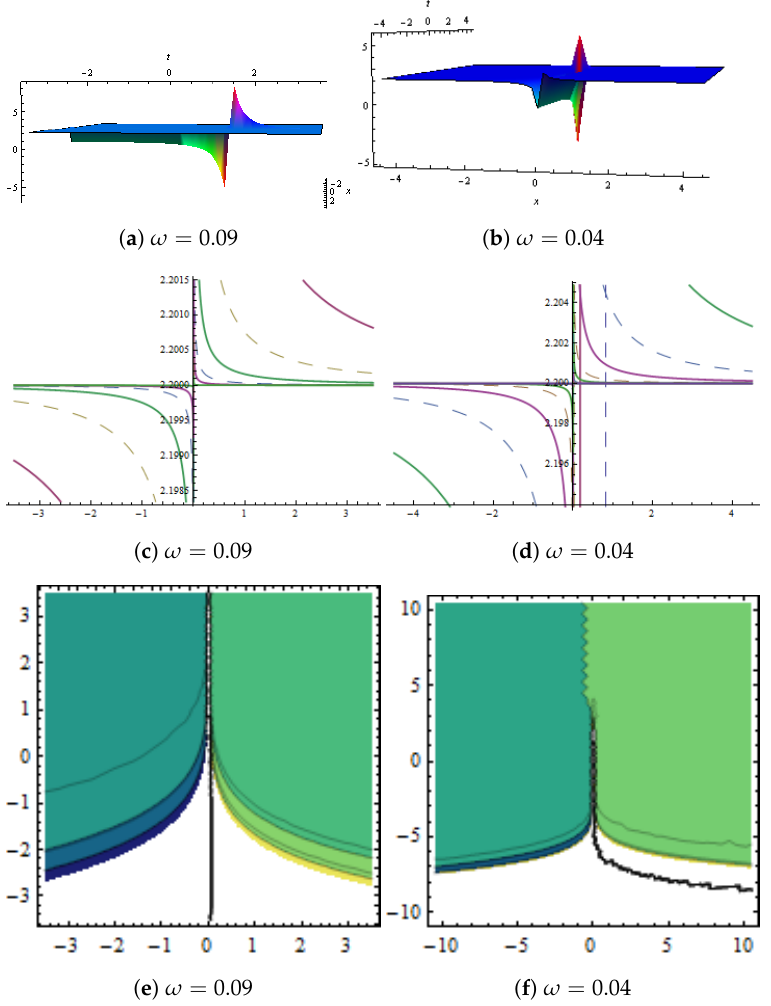
Figure 21. Graphical representation of solution v ( x , t ) in Equation (51) with β 2 = 0.2, β 3 = 0.5, ζ = 0, l 1 = 1.1, l 2 = 0.01, l 4 = 0.5, Q = 1.2, r 1 = 2.5, r 2 = 0.12, w 2 = 0.02, w 3 = 0.03, w 4 = 3.1, and φ = 1.4. ( a , b ) show 3D graph of lump wave, ( c , d ) represent 2D graph and ( e , f ) show contour